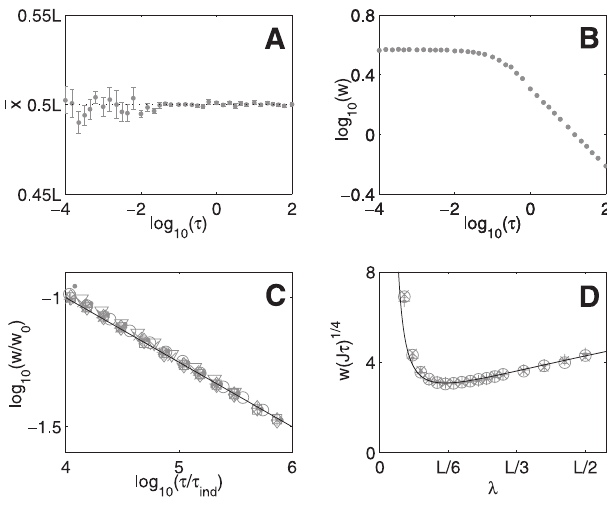
Figure 2. Two-Gradient Model in d ¼ 2 (A) The mean threshold position fluctuates about L /2 due to the symmetry of the system. (B) Variation of the width w as a function of averaging time. (C) Data collapse of the width as a function of averaging time, at long times, for a range of parameter values. The full line shows Equation 19 with ~ k 2 d ¼ 0.63 and a ~ ¼ 2.5. * indicates the standard parameter values. For the other datasets, parameter values were changed as follows: open circle, D ¼ 0.5 l m 2 s (cid:2) 1 ; open square, J ¼ 9 l m (cid:2) 1 s (cid:2) 1 ; 3 , D x ¼ 0.02 l m; closed circle, l ¼ 1 s (cid:2) 1 ; þ , l ¼ 0.25 s (cid:2) 1 ; diamond, L ¼ 7.5 l m; and inverted triangle, L ¼ 15 l m and D x ¼ 0.02 l m. (D) Plot of width as a function of decay length for averaging times: 3 , s ¼ 30 s; open circle, s ¼ 45 s; and þ , s ¼ 60 s. The full line shows the prediction from Equation 19.